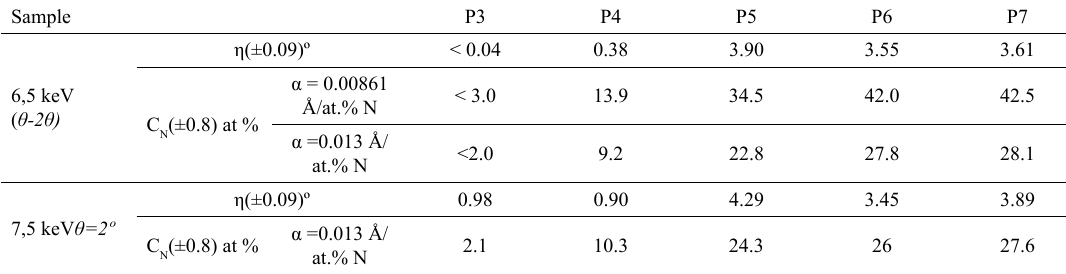
) and the triclinic angular distortion (η) 8 , calculated for γ N